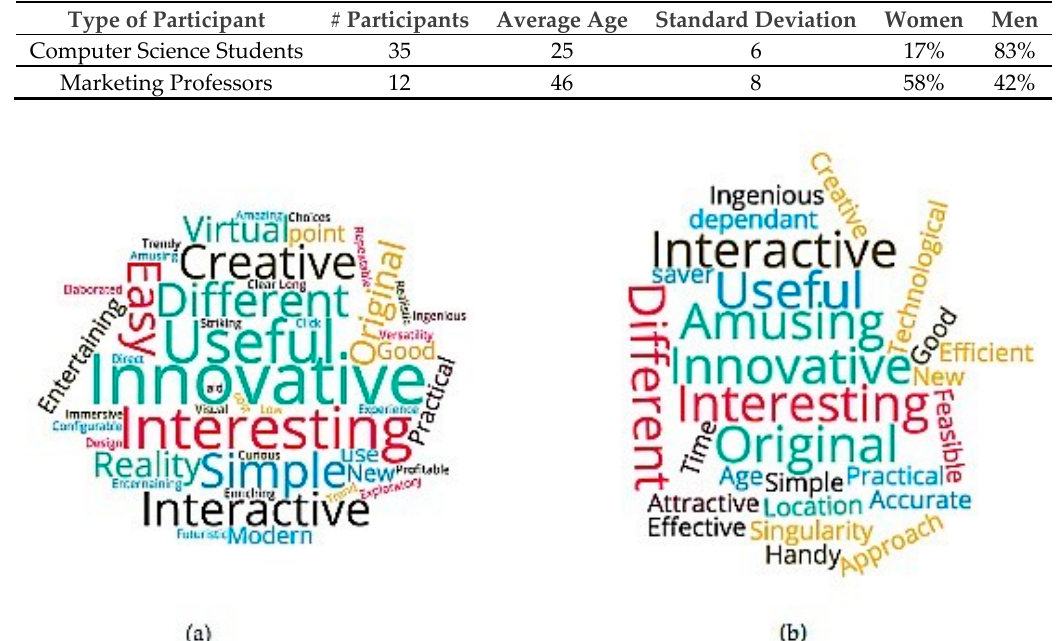
Table 3. Distribution of Participants in the Idea Evaluation.